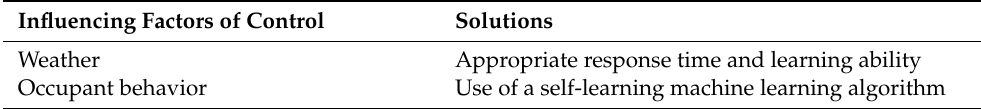
Table 3. Influencing factors of control and solutions.